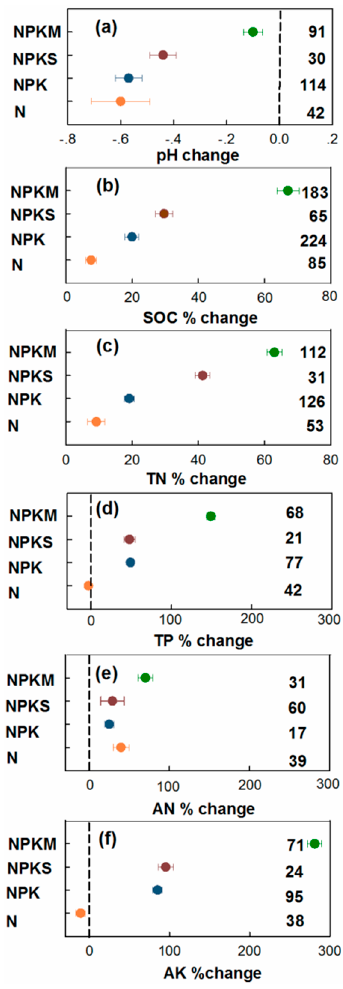
Figure 2. Effects of fertilizers (N, NPK (phosphorus, potassium and nitrogen), NPKS (NPK with straw returning), NPKM (NPK with manure)) on the soil chemical properties (pH ( a ), SOC ( b ), TN ( c ), TP ( d ), AN ( e ), AK ( f )) (SOC: soil organic carbon. TN: total nitrogen. TP: total phosphorus. AN: alkali − hydrolysable nitroge. AK: available potassium). Numbers of sampling data are in the rightmost column. Change and % change were compared to the control. Points and whiskers are mean values with the standard